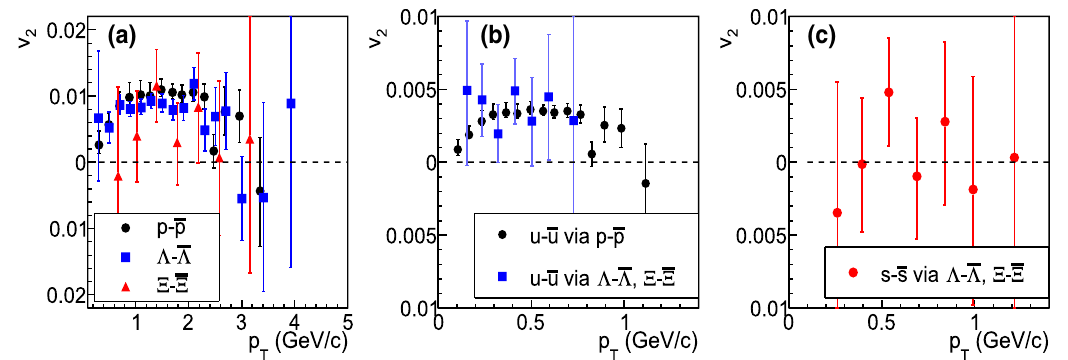
√ s NN = 39 GeV for 10–40% centrality. Data